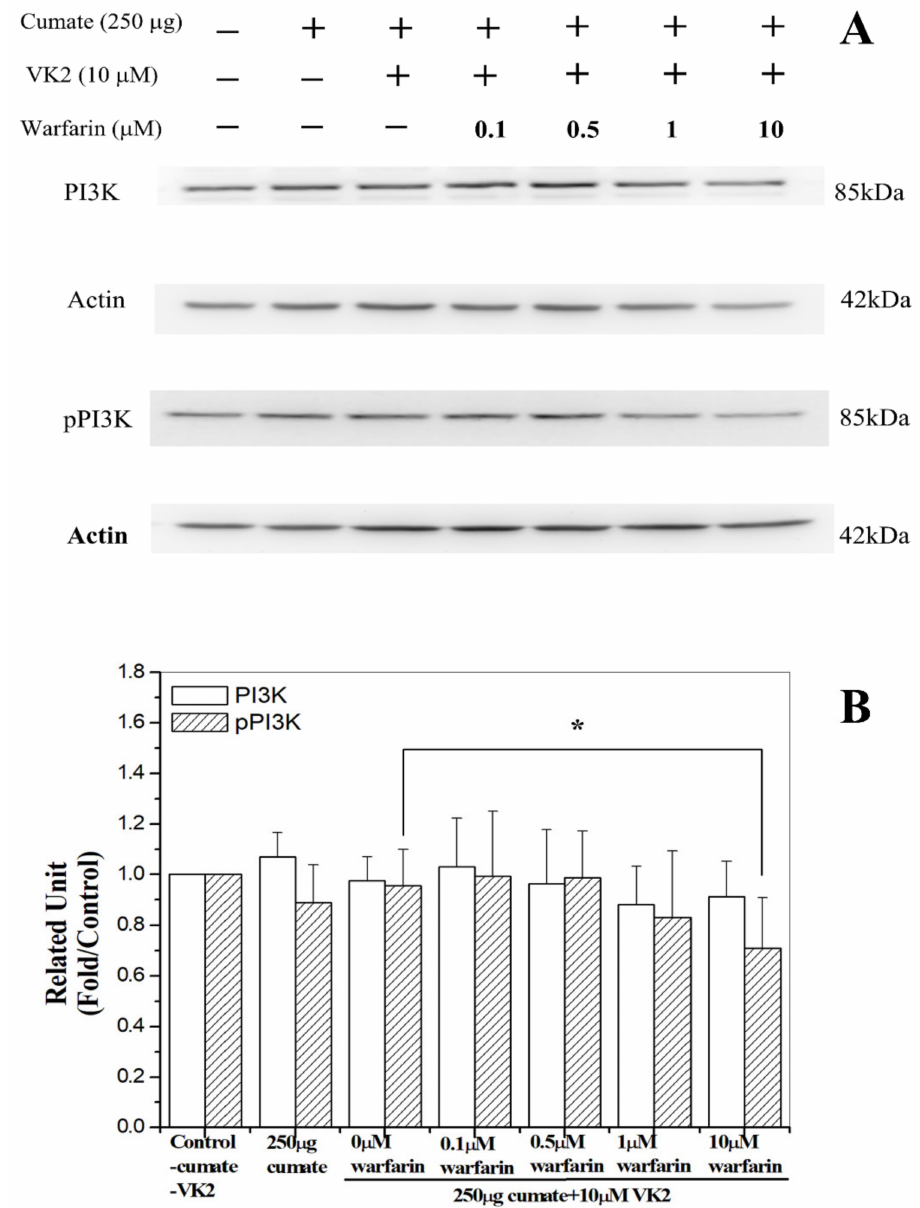
Figure 6. Warfarin inhibits vitamin K2-mediated PI3K phosphorylation. β -CTF/C6 cells were cultured with 250 µ g cumate, 10 µ M vitamin K2 (VK2), and 0–10 µ M warfarin doses for 72 h. ( A ) Western blot analysis with a monoclonal antibody against PI3K and pPI3K, and ( B ) relative PI3K or pPI3K level/actin. Data are means ± SD. * p <